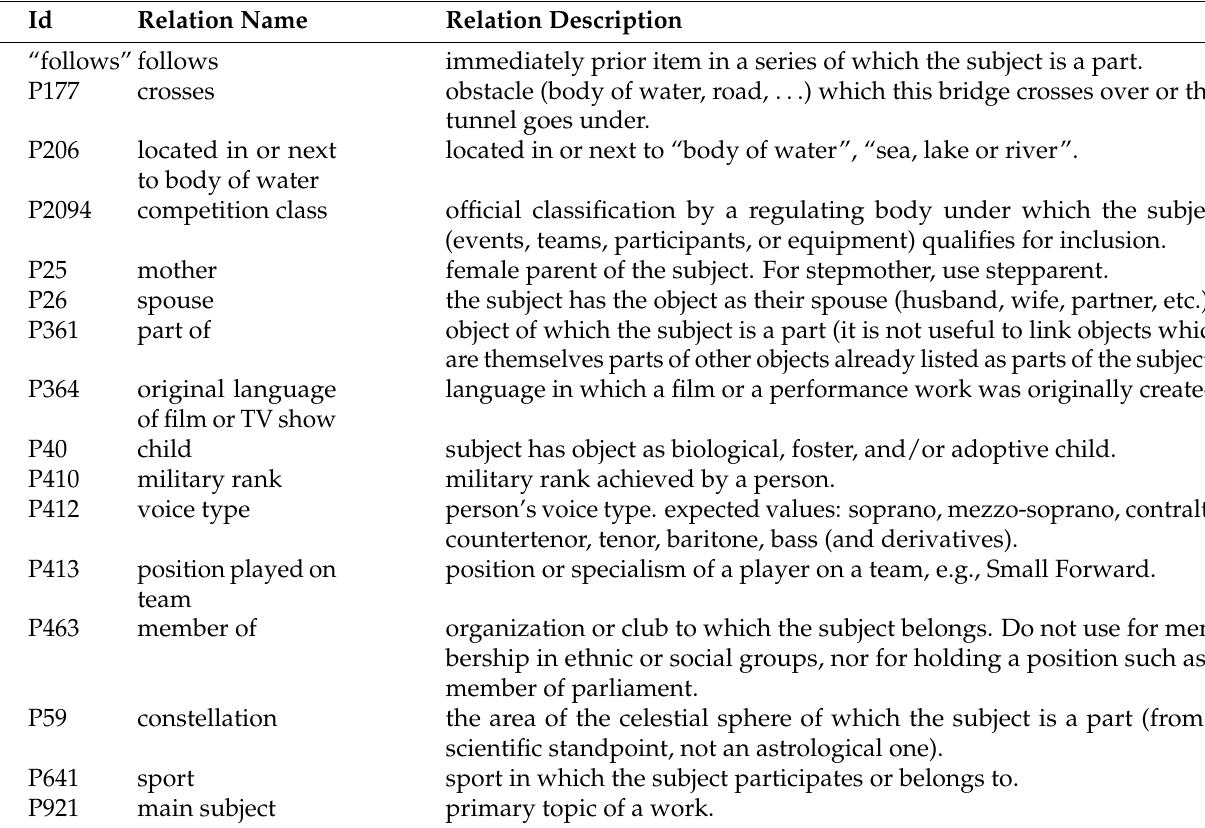
Table 2. Relation descriptions for the test